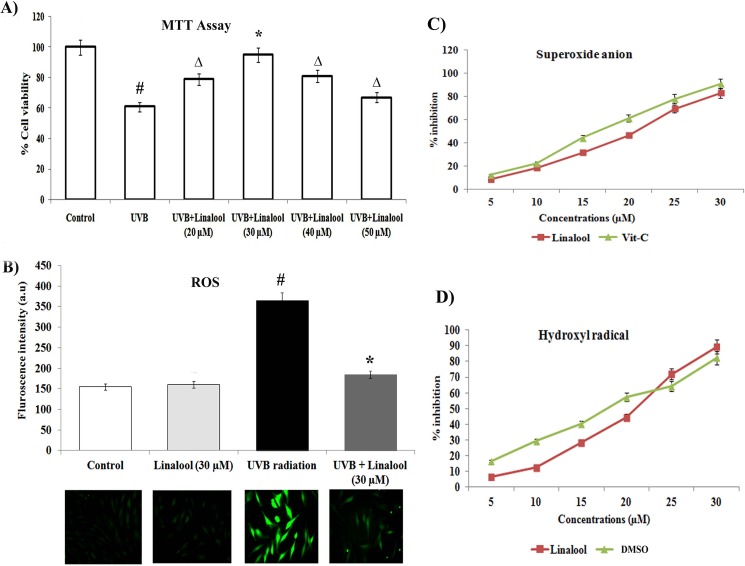
A. Cytoprotective effect of linalool on UVB-irradiated HDFa cells. The cells were treated with different concentrations of linalool (20–50 μM) and UVB-irradiated then cell viability was determined by MTT assay after 24 h incubation. Data expressed as means ± SD of six experiments in each group. Values not sharing a common marking (#,* and Δ) differ significantly at P < 0.05 (Duncan’s multiple-range test). B. The effect of linalool on UVB-induced ROS generation (DCFH-DA staining) in HDFa cells. ROS generation was examined with a fluorescence microscope (Cell Imaging Station, Life Technologies) under a green lamp (original magnification, 20X). Bar diagram represents fluorescence intensity made with excitation and emission at 485 ± 10 and 530 ± 12.5 nm respectively, using a multimode reader (Teccan, Austria). Data expressed as means ± SD of six experiments in each group. Values not sharing a common marking (# and *) differ significantly at P < 0.05 (Duncan’s multiple-range test). C&D. Free radical scavenging activity of linalool against superoxide radical and hydroxyl radical scavenging activity. Values are given as means ± SD of six experiments in each group.